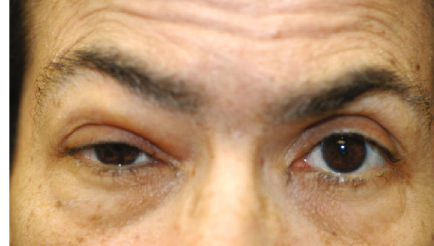
Figure 1: External photograph of the patient ’ s clinical appearance on presentation demonstrating right upper eyelid fullness and ptosis.